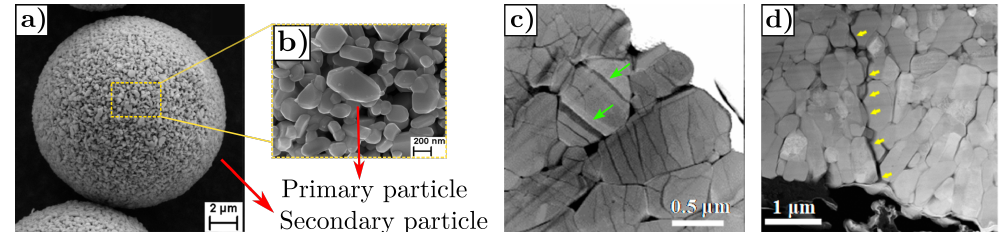
Figure 19. ( a , b ) SEM images of NMC secondary and primary particles. Reproduced with permission from [105], ©2020 American Chemical Society. ( c , d ) TEM images of the cross-section of discharged NMC cathode after 100 cycles: intragranular cracks within primary particles are marked with green arrows, whereas intergranular cracks developing along grain boundaries are marked with yellow arrows. Reprinted with permission by American Chemical Society from [106], Copyright